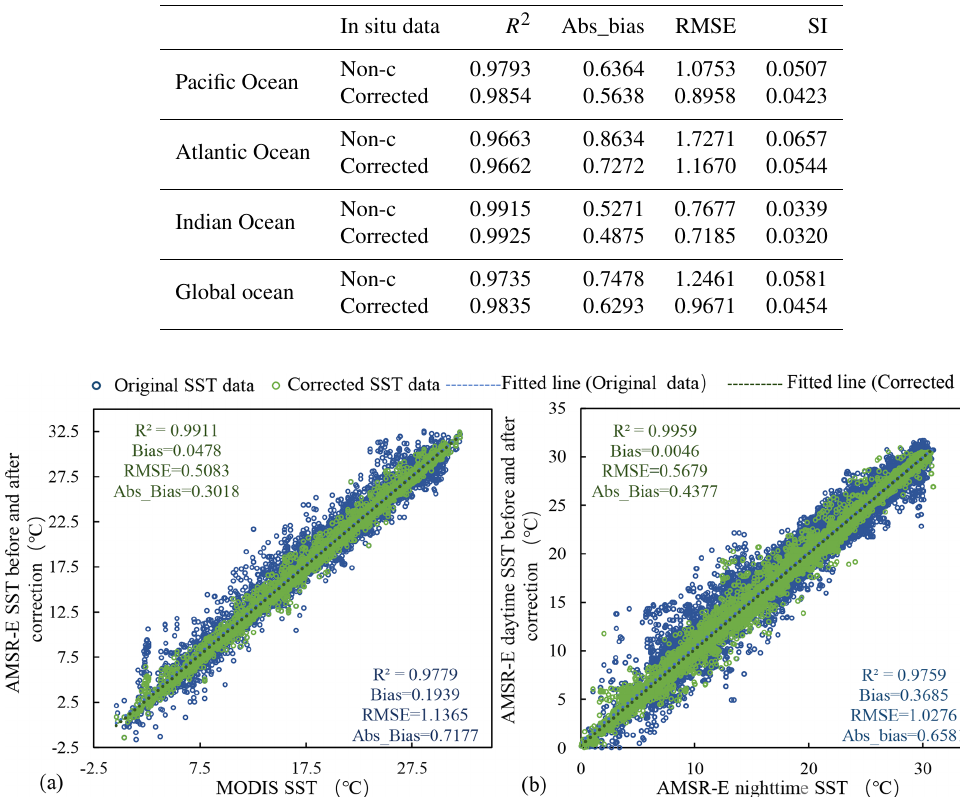
Table 1. Statistics of the validation results of original monthly MODIS SSTs against in situ SST measurements (non-corrected/corrected).